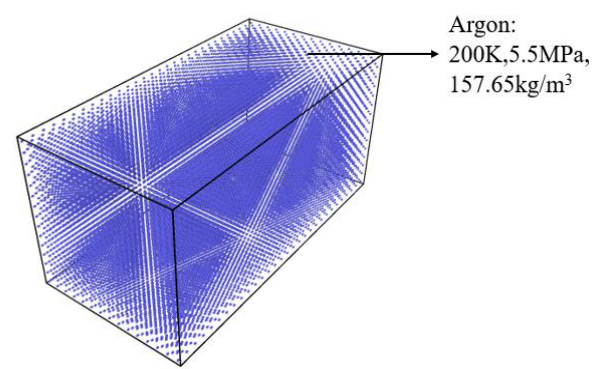
Figure 4. Right section of simulation box, size L x × L y × L z ( L x = 200 Å, L y = 400 Å, L z = 200 Å). Box is filled with supercritical argon (200 K, 5.5 MPa, 157.65 kg/m 3 ).